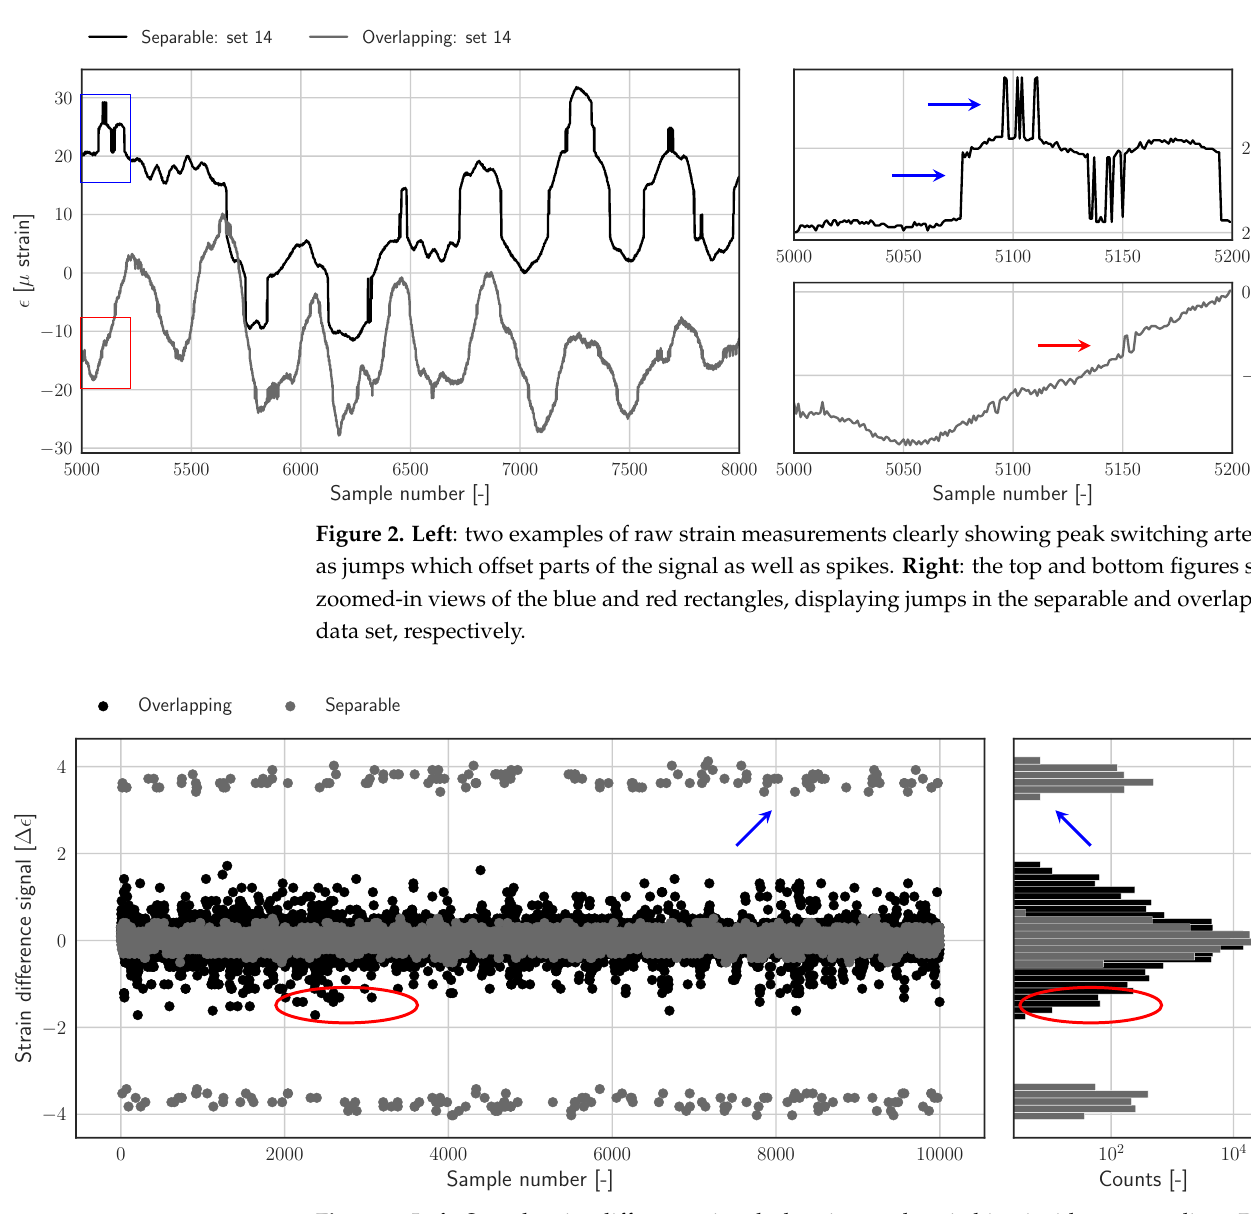
Figure 3. Left : Sample wise difference signal, showing peak switching incidents as outliers. Right : Histograms of the sample wise difference signals. Indicating the distribution of nominal difference samples and shifted difference samples, which can be overlapping or mutually exclusive (separable). Outlying difference samples in the separable and overlapping data set are indicated by blue and red annotations,